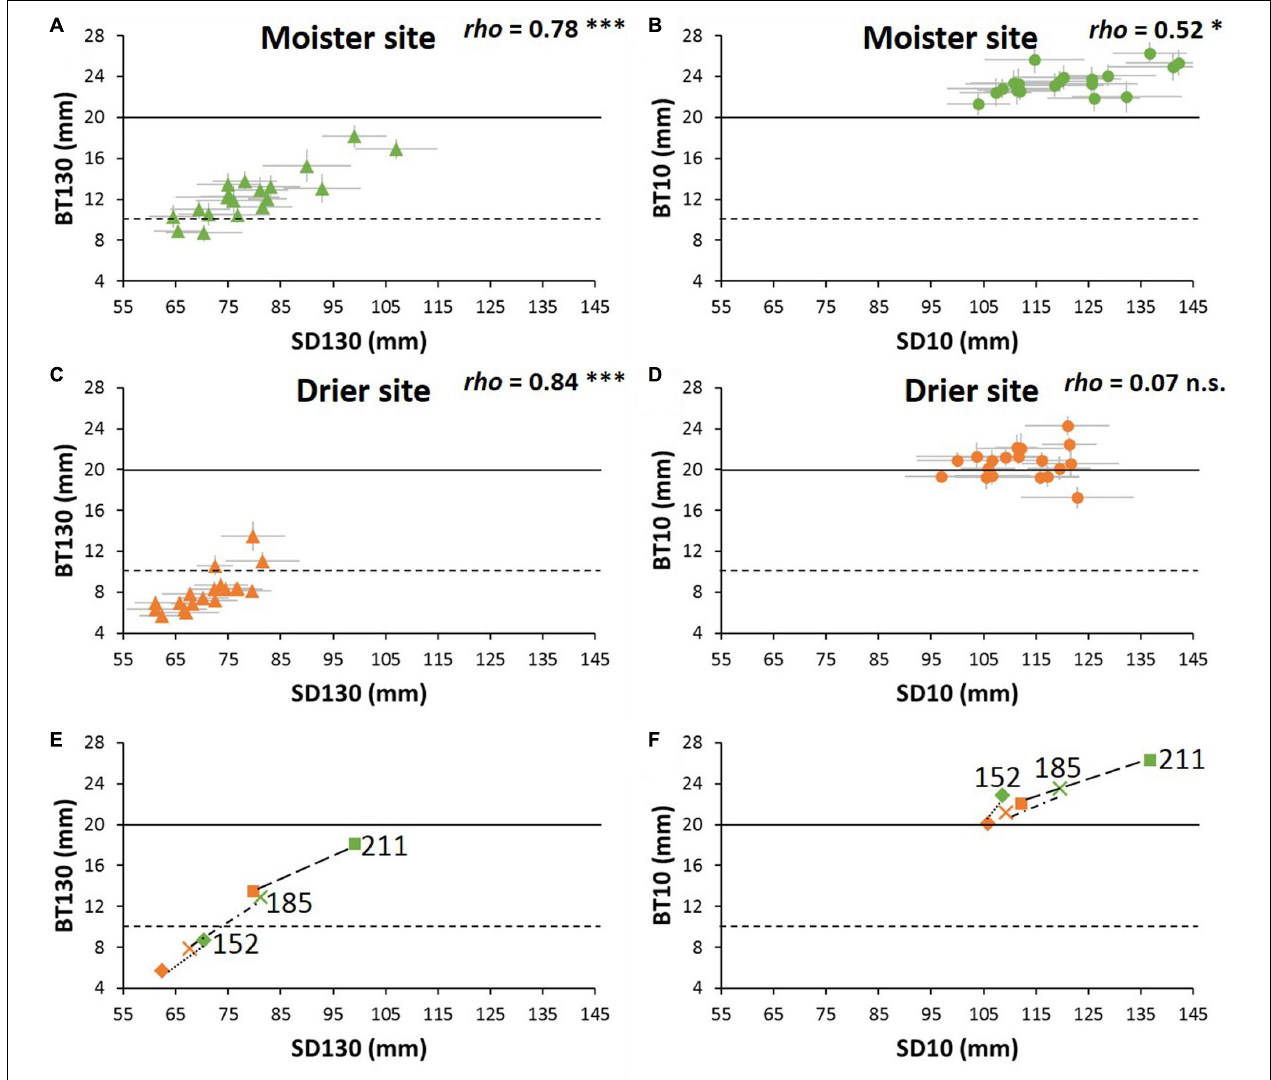
FIGURE 4 | (A–D) Bark thickness vs. sapwood diameter of P. halepensis populations at each experimental site. BT130 and BT10 are bark thickness at breast height and at the tree base, respectively, SD130 and SD10 are sapwood diameter at breast height and at the tree base, respectively. Horizontal black lines represent the assumed values of critical bark thickness for cambium survival (solid line: 10 mm; dashed-line: 20 mm). Significance for Spearman correlations between bark thickness and sapwood diameter at: ∗∗∗ P < 0.001, ∗∗ P < 0.01, ∗ P < 0.05, n.s. = no significant. (E,F) Variation between sites of the relationship between critical bark thickness and sapwood diameter of three representative P. halepensis populations. Numbers are the population code as in Supplementary Table S1 . Green symbols indicate moister site and orange symbols drier site ( n = 512